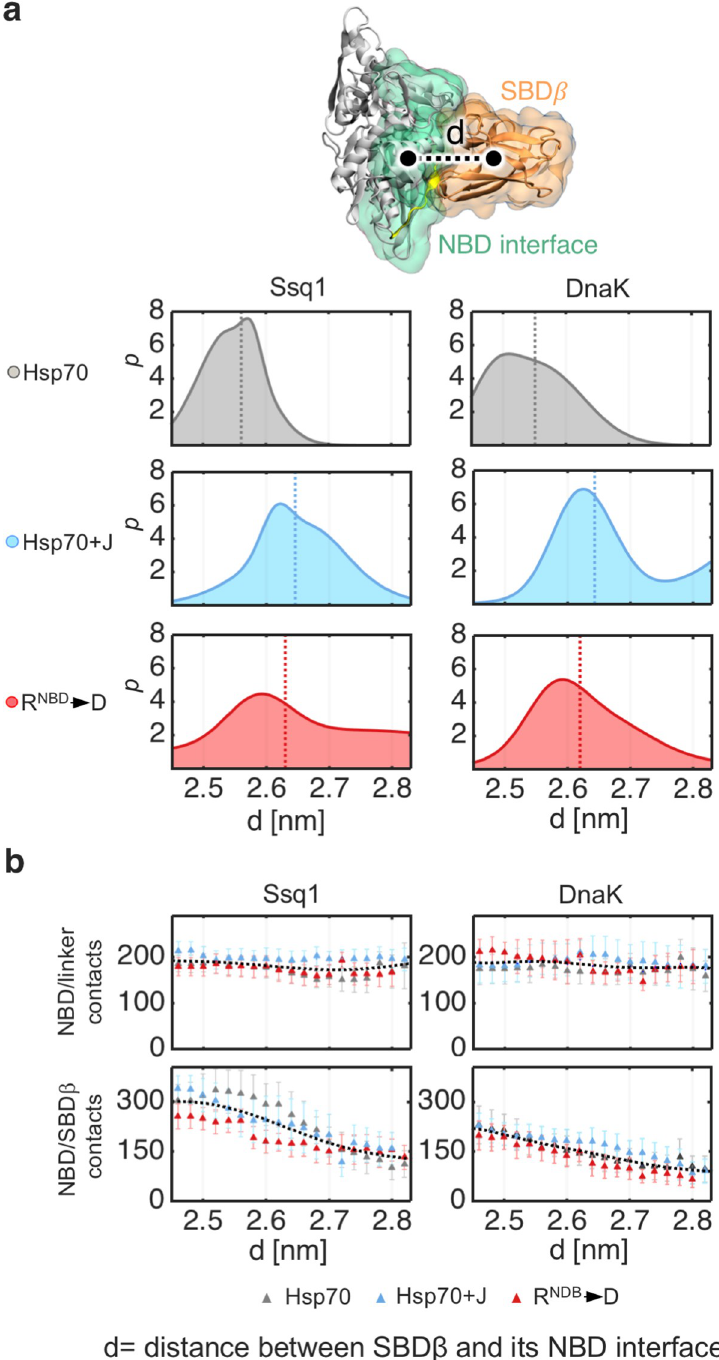
Fig 3. J-domain binding displaces SBD β from association with NBD. (a) Structural representation of the center of mass distance, d, between SBD β (orange) and its NBD interface (green). Probability distributions of the interdomain distance d for Ssq1 and DnaK; Ssq1 and DnaK alone (top panels, in grey), Hsc20-Ssq1 and DnaJ JD -DnaK complexes (center panels, in cyan), R NBD substitution variants Ssq1(R207D) and DnaK(R167D) (bottom panels, in red). Dashed lines represent an average d value for each distribution. (b) The number of contacts between NBD and linker and between NBD and SBD β , with increasing distance d; Ssq1 and DnaK (grey dots); Hsc20-Ssq1 and DnaJ JD -DnaK (cyan dots); Ssq1(R207D) and DnaK(R167D) (red dots). Contacts were defined as the number of non-hydrogen atoms within a 0.5 nm cutoff distance across the binding interface.